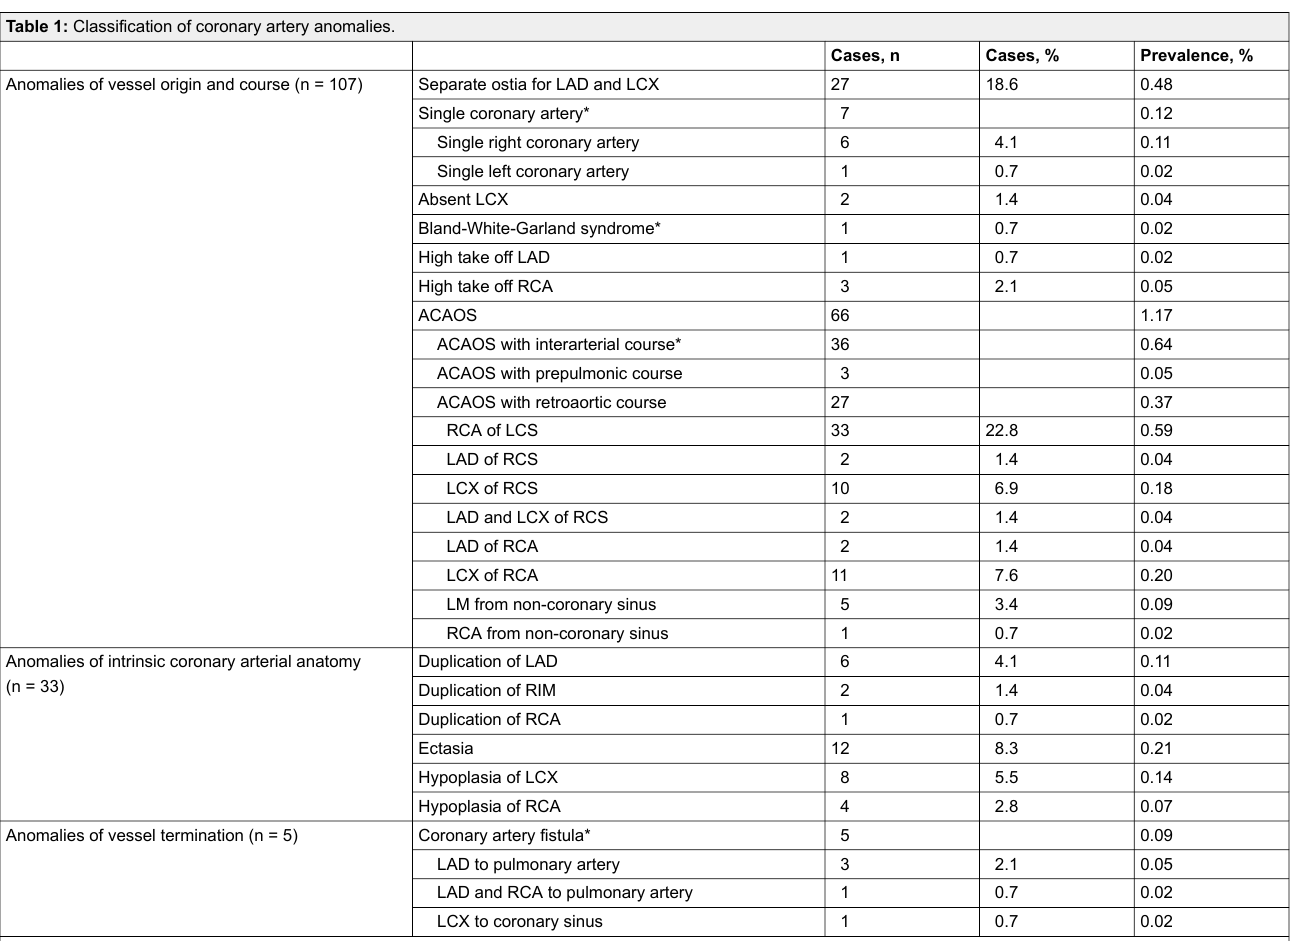
Table 1: Classification of coronary artery